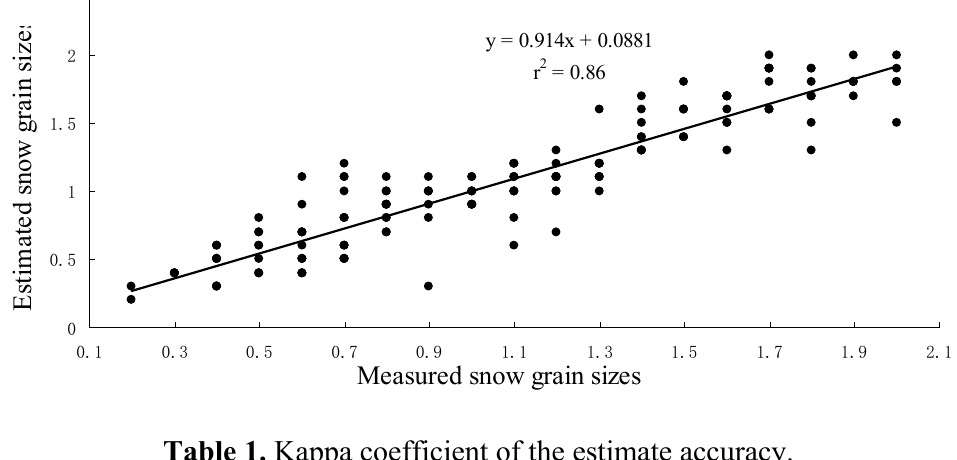
y = 0.914x + 0.0881 r 2 = 0.86